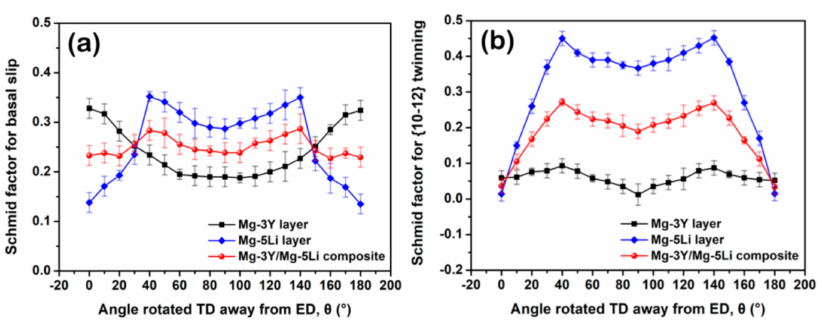
Figure 6. SFs for basal slip ( a ) and {10–12} extension twinning ( b ) of W3 layer, L5 layer and W3/L5 laminated composite along different tensile directions, covering the angles between 0 ◦ and 180 ◦ away from the ED to the